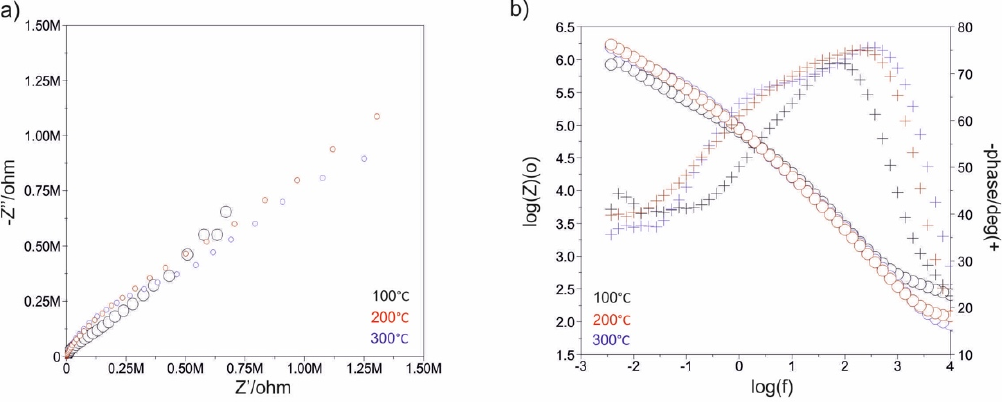
Figure 12. Impedance spectra determined for the ALD process in 1500 cycles for the electropolished samples: ( a ) Nyquist diagram, ( b ) Bode diagram.